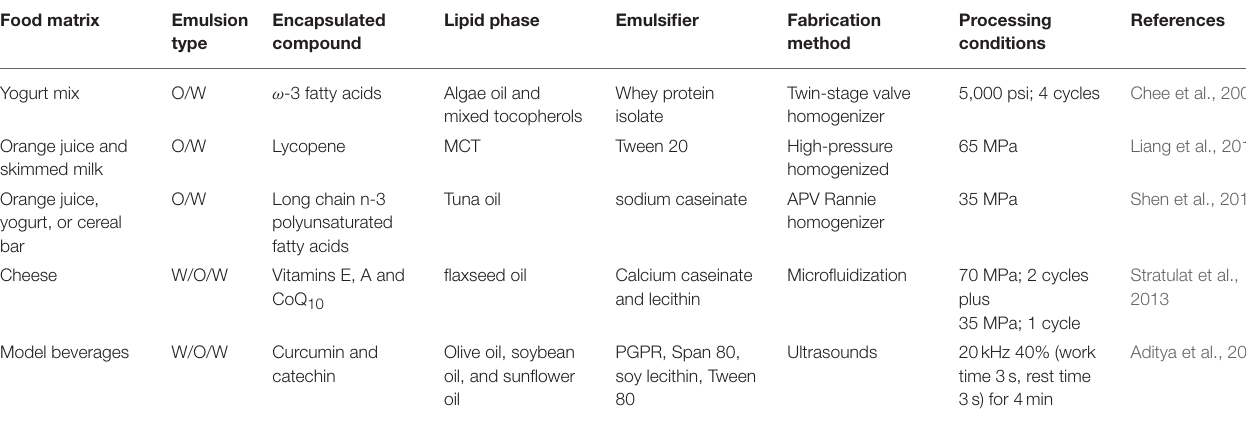
TABLE 1 | Review of the published works reporting emulsion-based nanostructures application in food